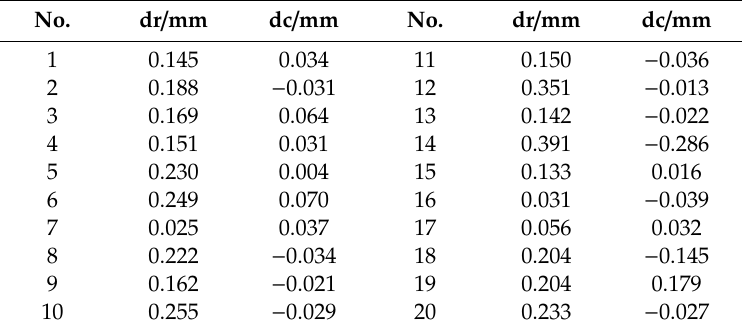
Table 3. The deviations of the